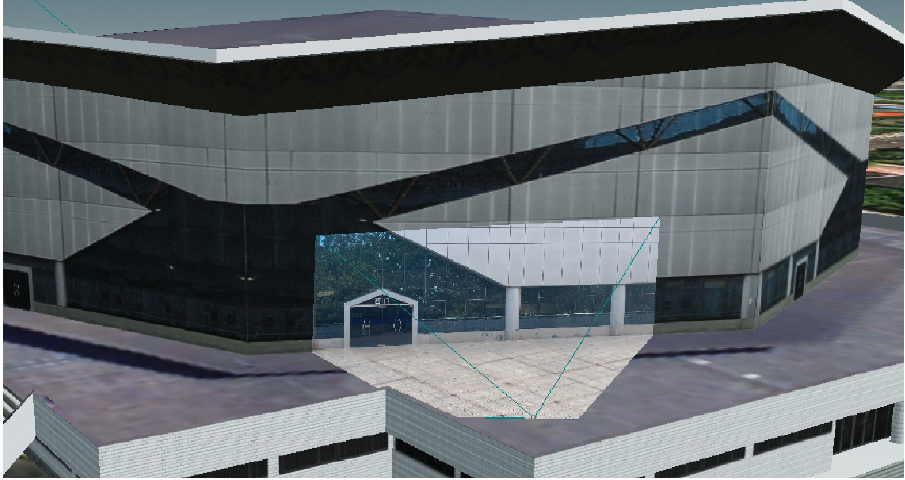
Figure 9. Experimental Results of Image Projection Texture Mapping.